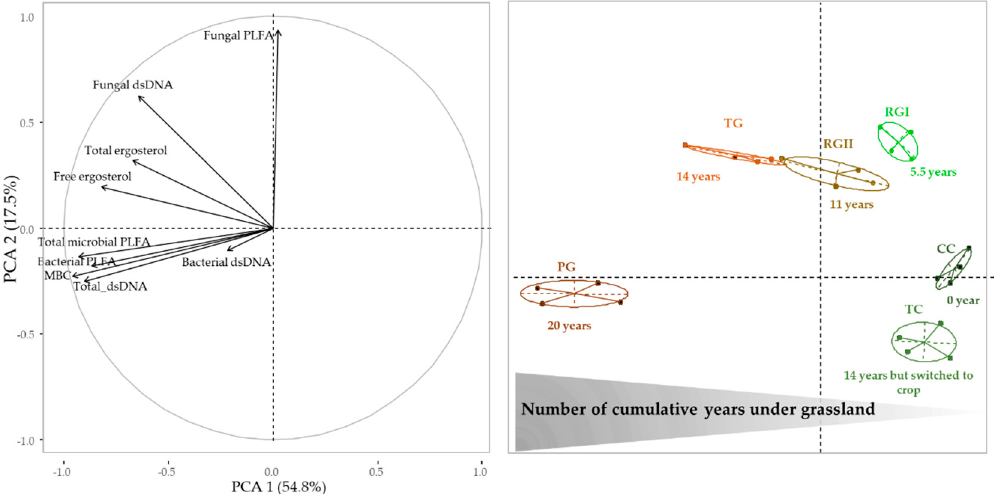
Figure 1. Principal component analysis and correlation circle of the abundance parameters of plots microbial communities.